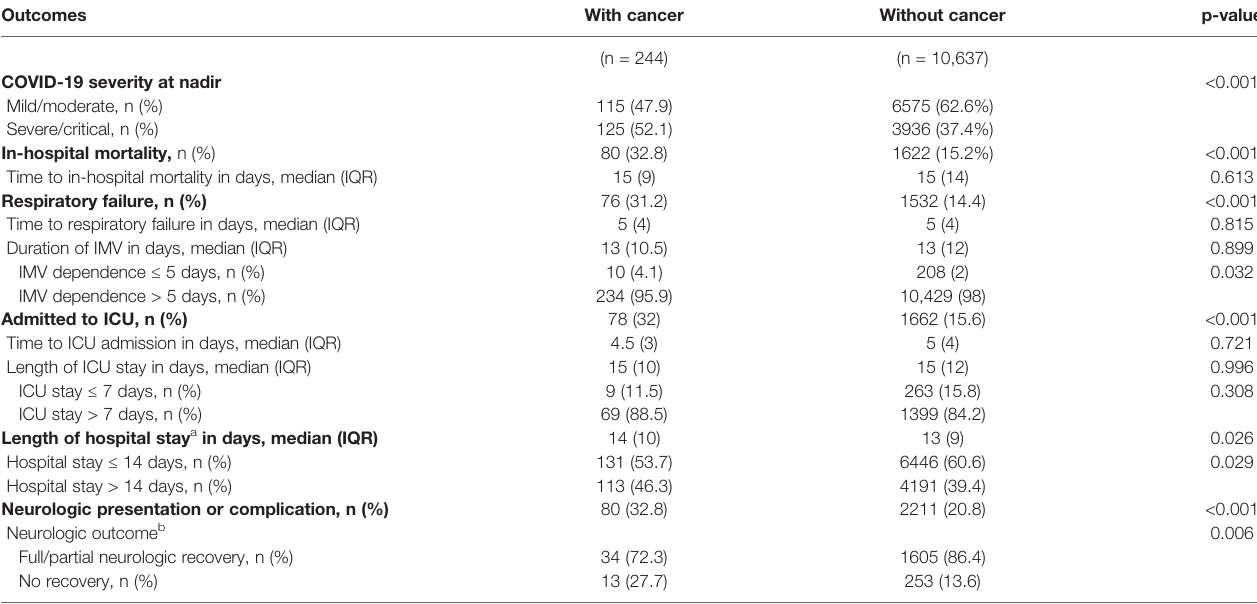
TABLE 2 | Clinical outcomes of COVID-19 patients strati fi ed according to having cancer or without. Outcomes With cancer Without cancer